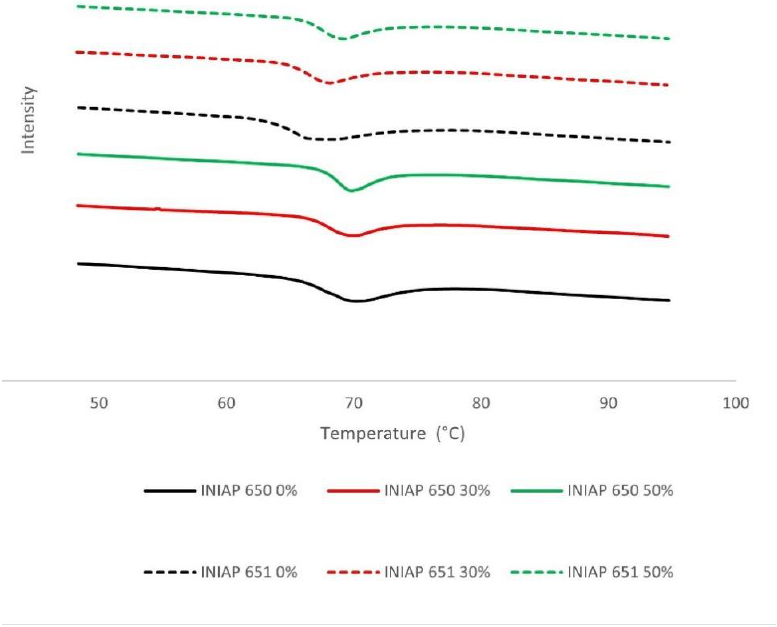
Figure 2. DSC spectra of different cassava starch varieties (INIAP 650, INIAP 651) and hydrolysis degree (0, 30, 50%).